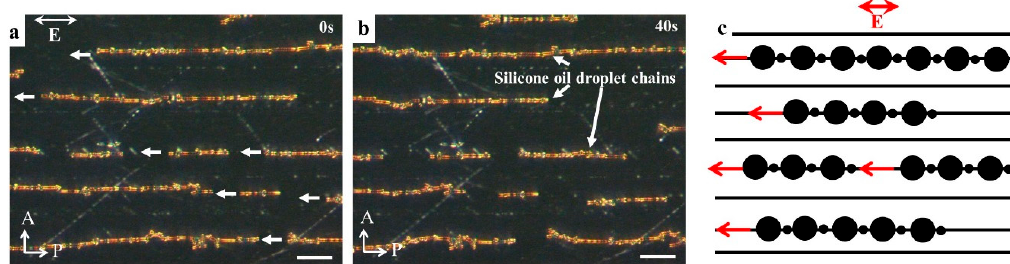
Figure 6. LCEP of ordered silicone oil droplet assemblies in LC. ( a , b ) Time sequence of the polarizing microscopy textures of silicone oil droplet chains formed by phase separation from the LC; ( c ) Scheme of LCEP transport of droplet chains. Each droplet is accompanied by a hyperbolic hedgehog shown as a small black disk. Scale bar is 50 μ m. P and A represent polarizer and analyzer.